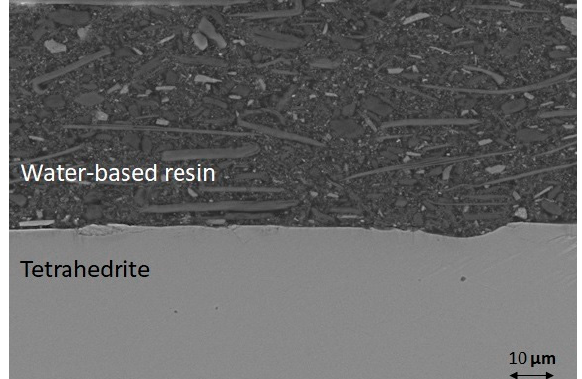
Figure 8. SEM image of cross-section of water-based resin THD coated after curing at 250 °C for 45 min under flowing Ar.